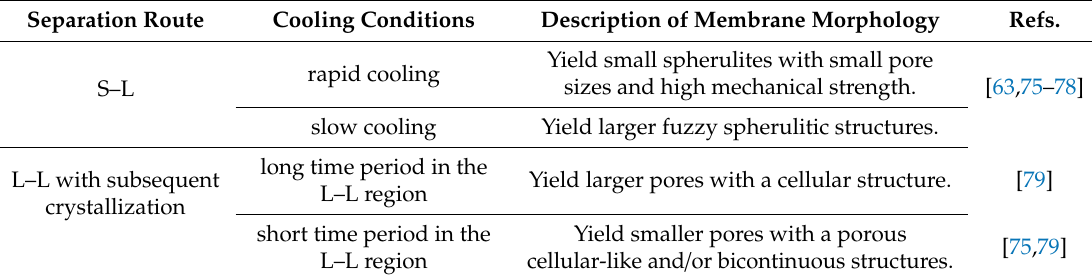
Table 2. E ff ect of TIPS conditions on the membrane